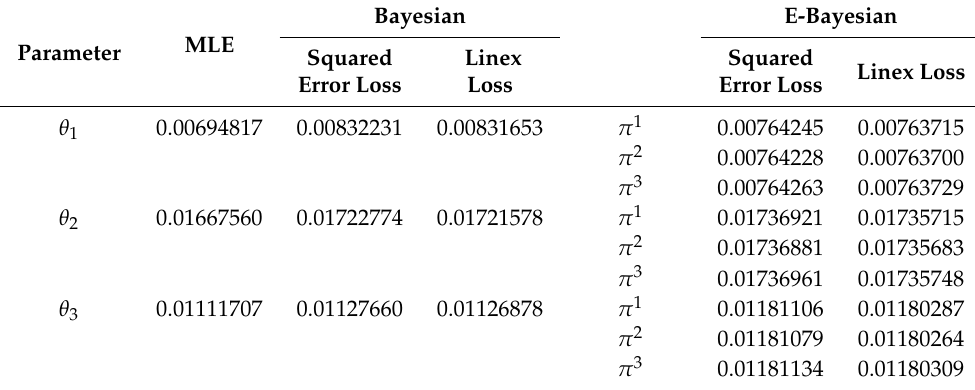
Table 13. Point estimates for unknown parameters under HIV infection competing risk data.